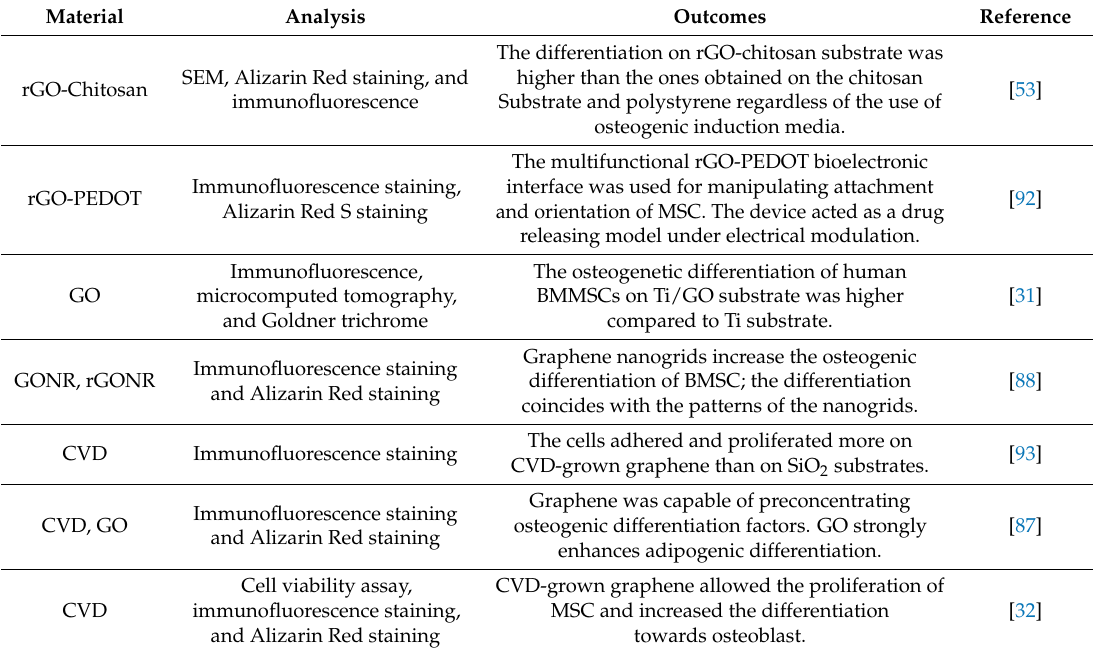
Table 1. Osteogenic potential of graphene in bone tissue engineering